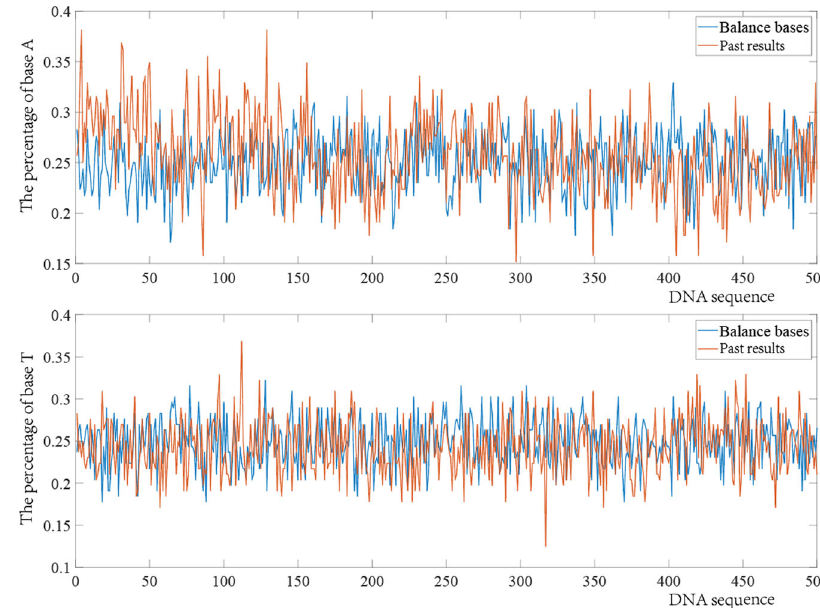
Fig. 3 The in fl uence of high base balance constraint on A and T base